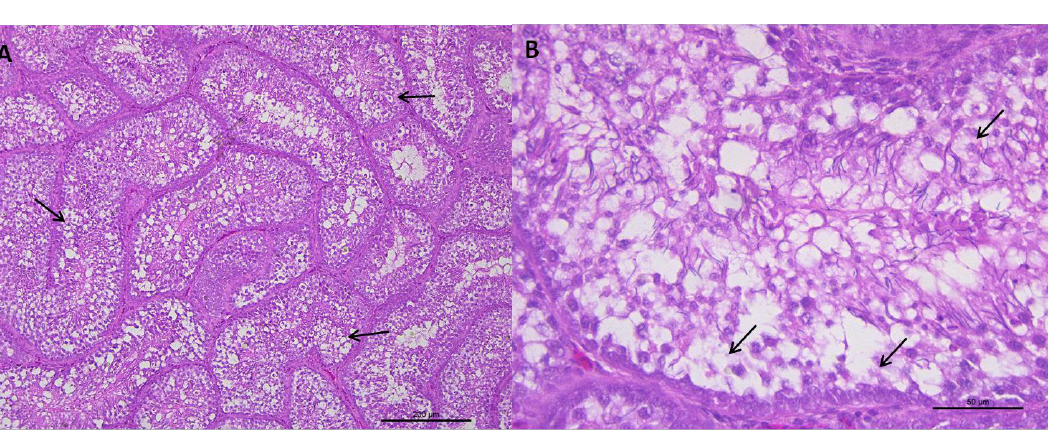
Figure 1. (A) Representative transverse section of seminiferous tubules of the testes of roosters from 30 weeks of age with standard weight and a value of 3 for testicular integrity. Small dark bodies are observed that correspond to different stages of sperm maturation. HE staining (bar: 200 μm). (B) Area extension of photograph A, where the epithelium of the seminiferous tubule is shown (arrow). This epithelium is formed by germ cells, which, as they move towards the tubule lumen, can be found in different spermatogenesis stages. Towards the tubule lumen, mature sperm clusters can be seen in which the head and the tail can be differentiated (double-headed arrow). HE staining (bar: 50 μm).